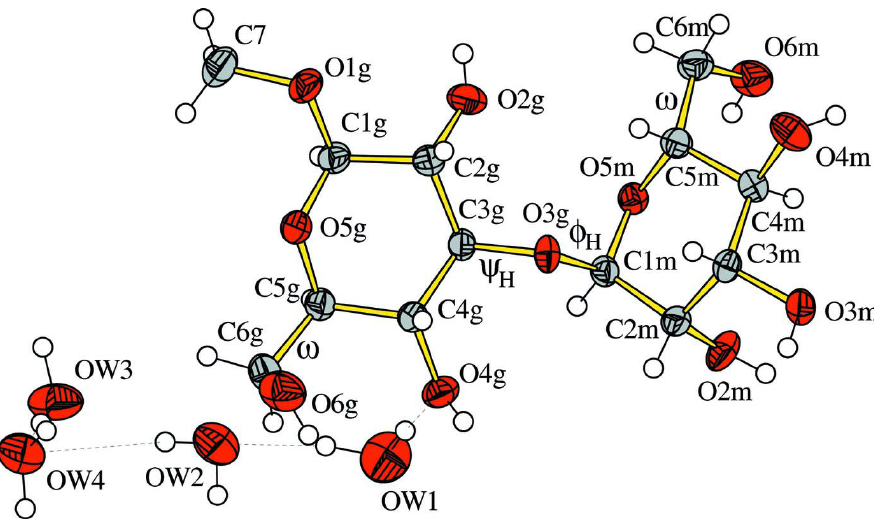
Figure 1 Molecular structure of the title compound, showing 50% probability displacement ellipsoids and the atom numbering scheme. H atoms are shown as small spheres of arbitrary radii.